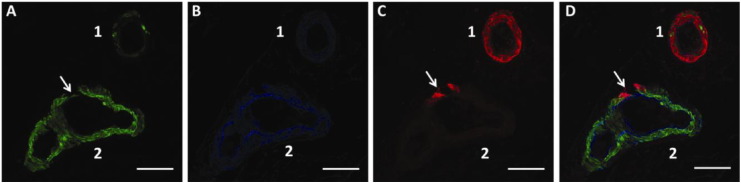
Single colour channel images in series (A–C) and the overlay (D) showing triple immunofluorescence labelling of two leptomeningeal arteries from a severe CAA brain. A) Smooth muscle actin (SMA); B) collagen IV; C) Aβ; D) overlay. Vessel 1 diameter = 71.866 μm, vessel 2 diameter = 80.151 μm. (→) marks a key region of interest where initial Aβ deposition correlates to the only region of reduced SMA in vessel 2. Scale bar: 50 μm.